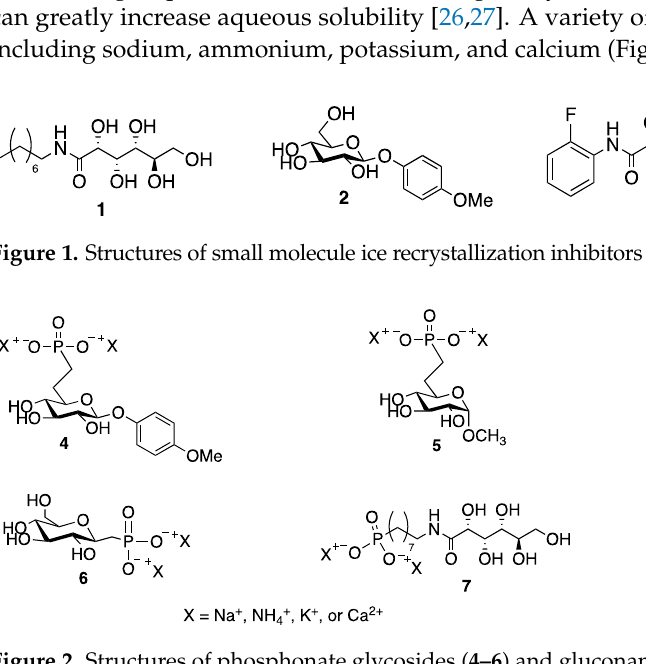
Figure 2. Structures of phosphonate glycosides ( 4–6 ) and gluconamides ( 7 ).